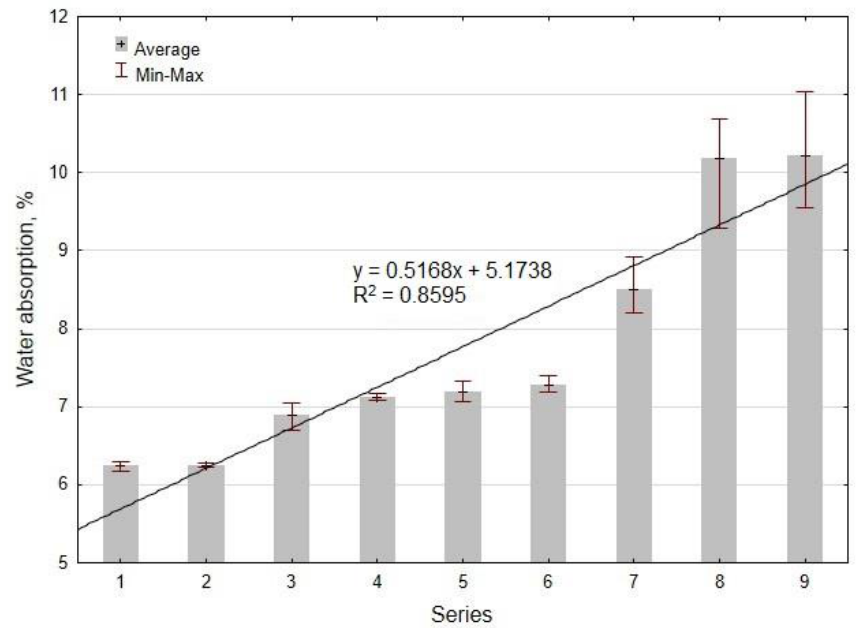
Figure 11. The average test results of the water absorption of the geopolymer mortars with hemp.